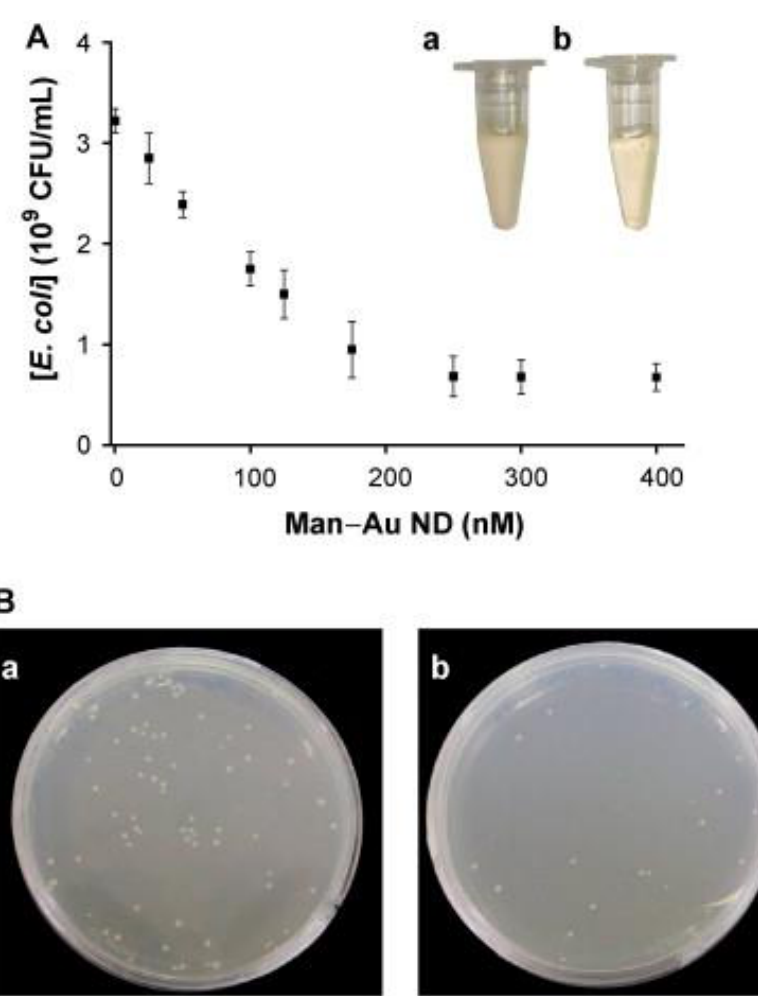
Figure 3. ( A ) Antibacterial effect of Man-AuNCs with their concentrations from 0 to 400 nM. ( B ) Colony formation of E. coli on LB agar plates in the (a) absence and (b) presence of Man-AuNCs (250 nM). Insets of Figure 3A indicate photographs of E. coli (1.0×10 8 CFU/mL) grown for 10 h in the LB medium in the (a) absence and (b) presence of Man-AuNCs (250 nM). Reproduced with permission from Reference [74]. Copyright © 2011, Elsevier.